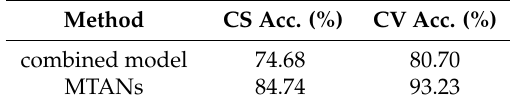
Table 6. Performance comparison between the combined model and MTANs on the NTU RGB+D